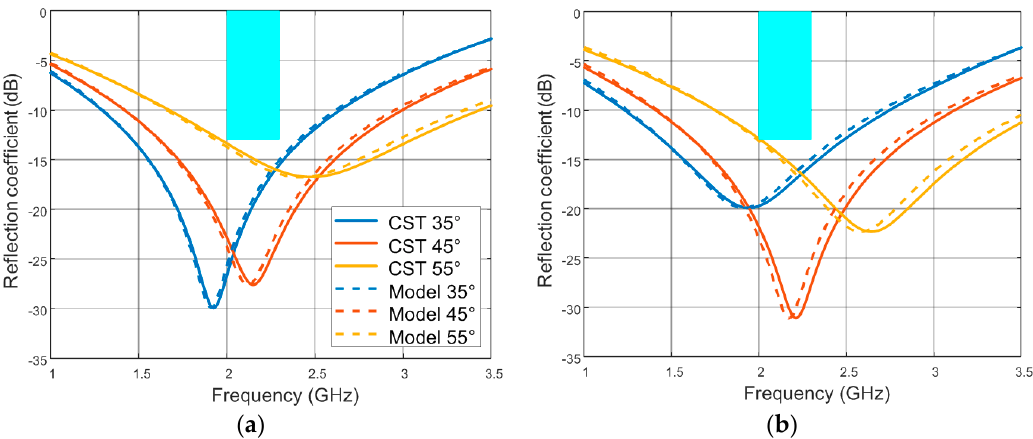
Figure 3. Comparison between TL model and EM simulation of sector A for TE polarization ( a ) and TM polarization ( b ). The rectangle corresponds to an objective of − 13 dB in the band [2 GHz, 2.3 GHz]. Table 1. Geometrical dimensions of sector A for each polarization.